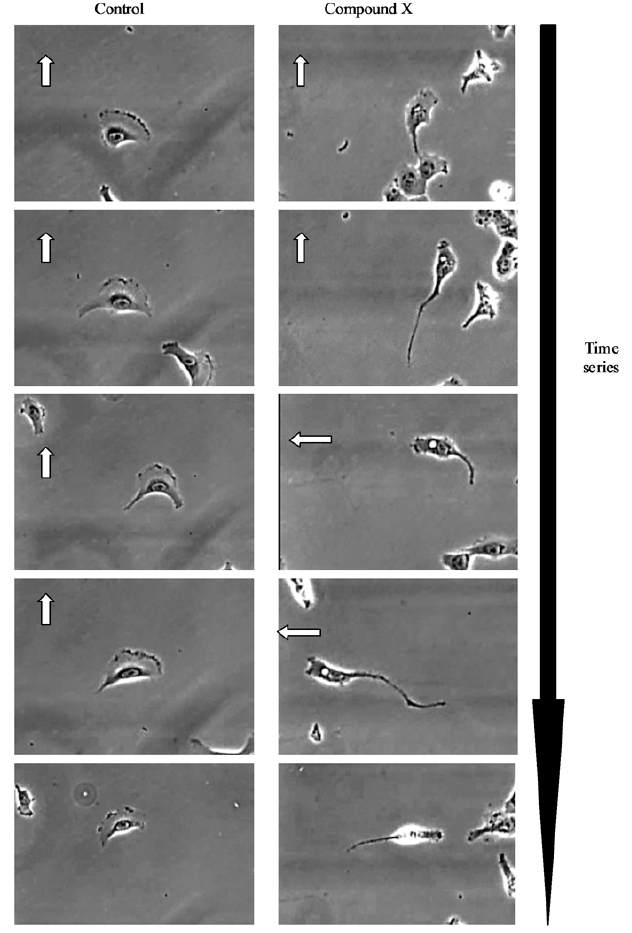
Figure 2. Kinetic profiling of cell migration response. Time lapse images obtained from the IncuCyte platform demonstrating the polarity and morphology of migrating HT1080 fibrosarcoma cells following compound treatment. White arrow denotes direction of cell movement. The time resolved images clearly demonstrate the impact that compound X has upon the adhesive mechanisms regulating cell motility with clear defects in lamellipodia formation at the leading edge and uropod retraction at the trailing edge (Figure